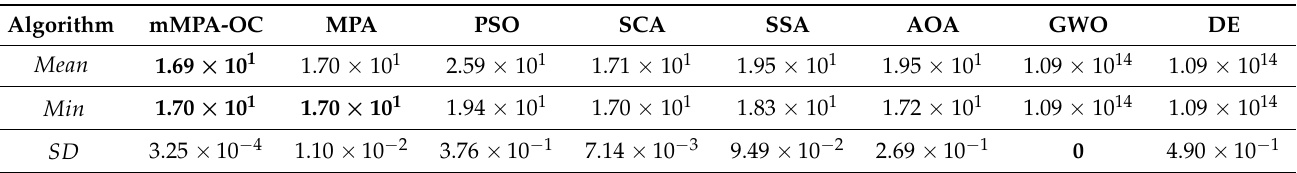
Table 20. Comparison results between mMPA-OC and the other seven meta-heuristics algorithms on the welded beam design problem.